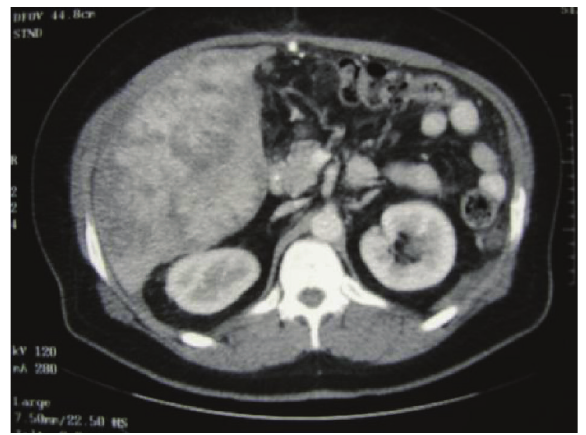
Figure 5: Three month followup CT scan abdomen with contrast demonstrating no enhancing tumor remaining following TACE.